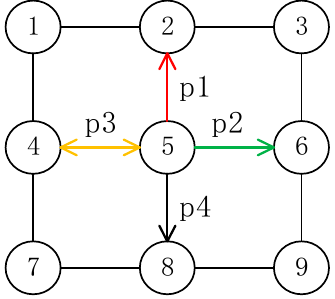
Figure 6. Forwarding interface selection.